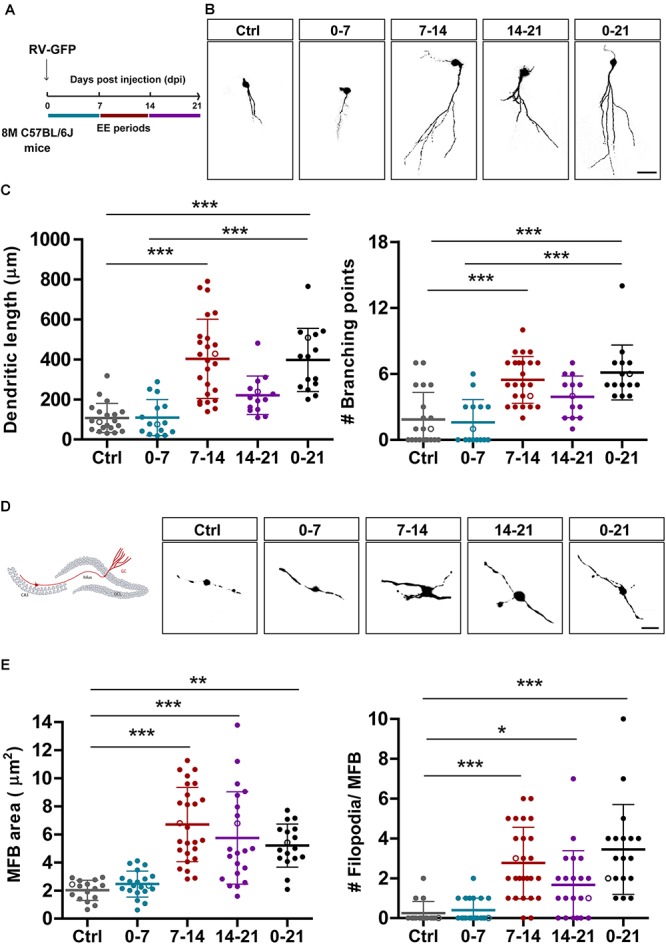
EE triggers structural remodeling of new GCs. (A) Experimental design. RV-GFP injection was followed by exposure to 7 days of EE at the indicated 1-week windows or during the entire experiment (0–21). Morphological parameters were analyzed in GFP-GCs at 21 dpi after confocal imaging. (B) Representative confocal images of 21-dpi GFP-GCs for the different groups. Scale bar, 25 μm. (C) Dendritic complexity (length and branching points) for the different windows of EE exposure. (∗∗∗) denotes p < 0.001 after Kruskal–Wallis test followed by Dunn’s post hoc test. Sample sizes (neurons/mice): 20/4 (Ctrl), 15/3 (0–7), 25/5 (7–14), 14/4 (14–21), and 15/4 (0–21). (D) MFB morphology in CA3 was analyzed for all groups, and representative images are shown on the right panels. Scale bar, 5 μm. (E) (∗), (∗∗), and (∗∗∗) denote p < 0.05, p < 0.01, and p < 0.001 after Kruskal–Wallis test followed by Dunn’s post hoc test. Sample sizes: 16/4 (Ctrl), 20/4 (0–7), 26/5 (7–14), 21/4 (14–21), and 17/3 (0–21). Horizontal bars denote mean ± SEM. Open circles correspond to sample neurons/boutons.